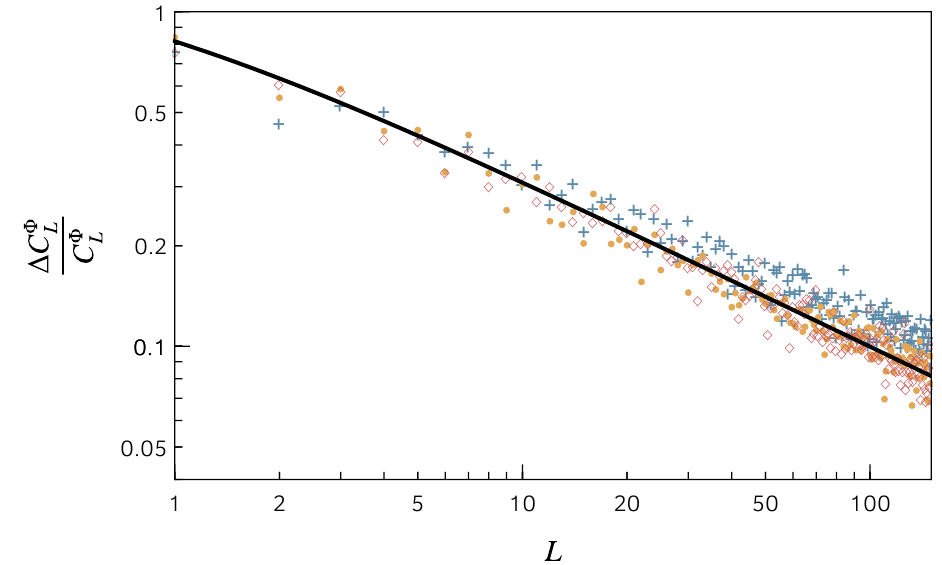
Figure 5 . (cid:1) C (cid:8) =C (cid:8) as a function of L . (cid:1) C (cid:8) =C (cid:8) is the ratio between the standard deviation L L L L and the mean of C (cid:8) from the simulations with di(cid:11)erent choices of (cid:24) . The blue, yellow and red L markers show the value of (cid:1) C (cid:8) =C (cid:8) from our simulations with (cid:24) = 1 ; 10 ; 100, respectively. The L L q 2 black solid line is the expected cosmic variance value of (cid:1) C (cid:8) =C (cid:8) = . These results come L L 2 L +1 from 60 simulations per value of (cid:24)